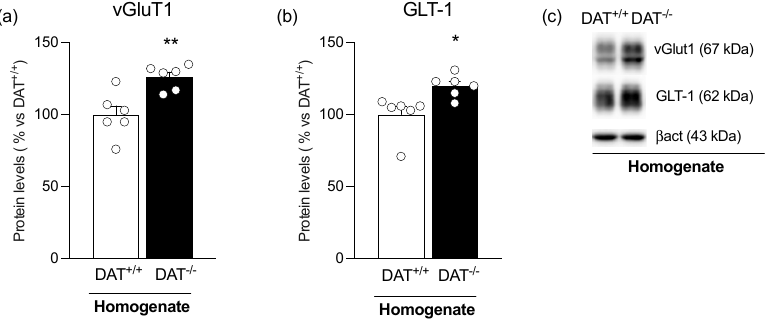
Figure 1. Protein expression level of vGluT1 ( panel a ) and GLT-1 ( panel b ) in the medial prefrontal cortex (mPFC) of DAT+/+ and DAT − / − rats. In panel ( c ), representative immunoblots are shown for GLT-1, vGluT1, and β -Actin. Results obtained in the whole homogenate are expressed as mean percentage ± mean standard error from six independent determinations for each experimental group. Unpaired Student’s t -test * p < 0.05, ** p < 0.01 vs DAT+/+ rats.